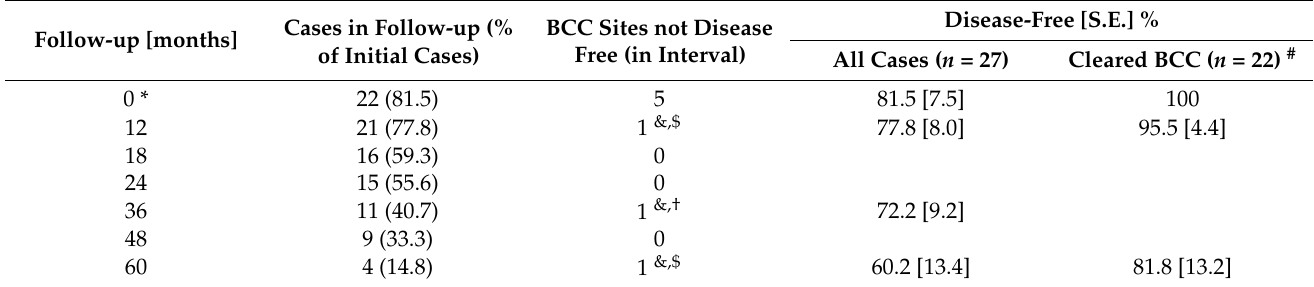
Table 1. Probability of disease-free tumor sites (standard error, S.E.) as a function of follow-up time after treatment initiation with immunocryosurgery for basal cell carcinoma (BCC) that had relapsed after standard surgical excision (Kaplan–Meier method).